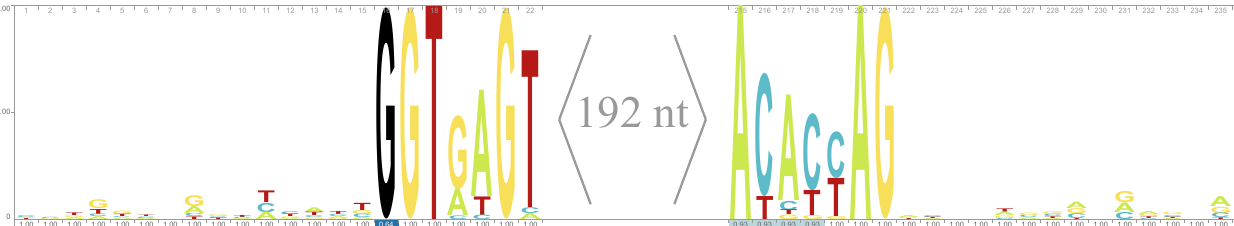
Figure 5. Sequence logo of the (stw)intron–exon junctions of 28 sister (stw)introns in Hypoxylon sp. CO27-5. The logo visualises the extent of nucleotide conservation in a multiple sequence alignment and highlights conservation patterns adjacent to the (stw)intron–exon junctions of sister (stw)introns. The 28 sister (stw)intron sequences in the trimmed alignment shown in Figure 3b were extended to include their respective bordering exonic sequences (15 nt on each side). For convenience, the intron–exon junctions were aligned precisely by further manually trimming of the 5 (cid:48) terminus of HCOc021A and the 3 (cid:48) terminus of HCOc153A (2), while the additional G (near 3 (cid:48) ) unique to six of the type-2 cropped sister introns (see Section 3.4) was also removed. However, all exonic sequences included in the input alignment of the logo are authentic. Observed counts were used in processing. The relative sizes of the four nts indicate their frequency at each individual position. The height of the nt stack equals the information content at each position. (D1,2) stwintrons start with GGT (GGU): the black G (position 16) in the logo is thus intronic and corresponds to the 5 (cid:48) -donor G 1 of the external intron of the stwintron (occupancy: ~0.64). For clarity, only the sections of the logo in the direct proximity of the (stw)intron–exon junctions are shown.